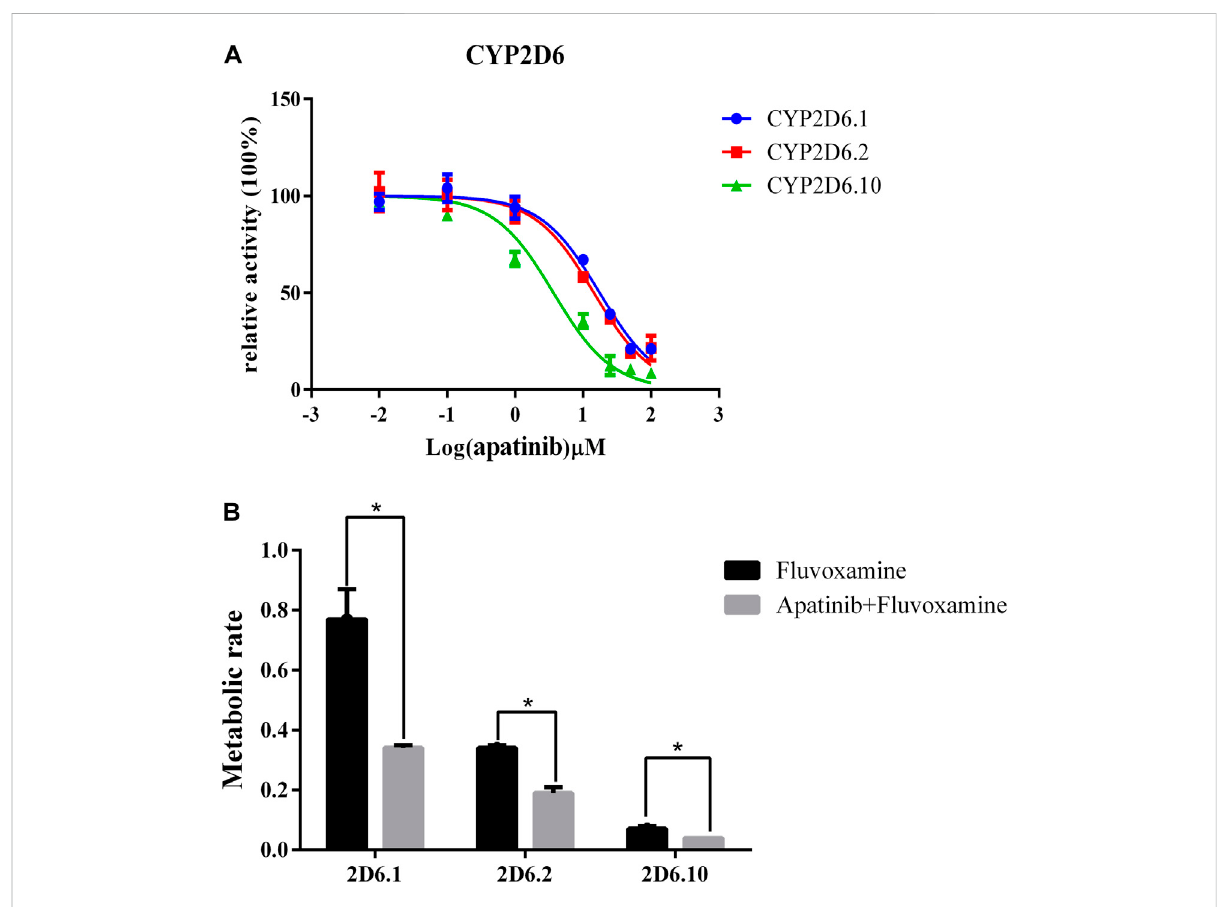
FIGURE 6 Thedifferenteffectofapatinibon fl uvoxaminemetabolisminthreeCYP2D6variants. (A) Thecatalyticpro fi leof fl uvoxamineinCYP2D6.1,2and 10. (B) The effect of apatinib on the metabolic rate of fl uvoxamine in CYP2D6.1, 2, and 10, n = 3, * p <